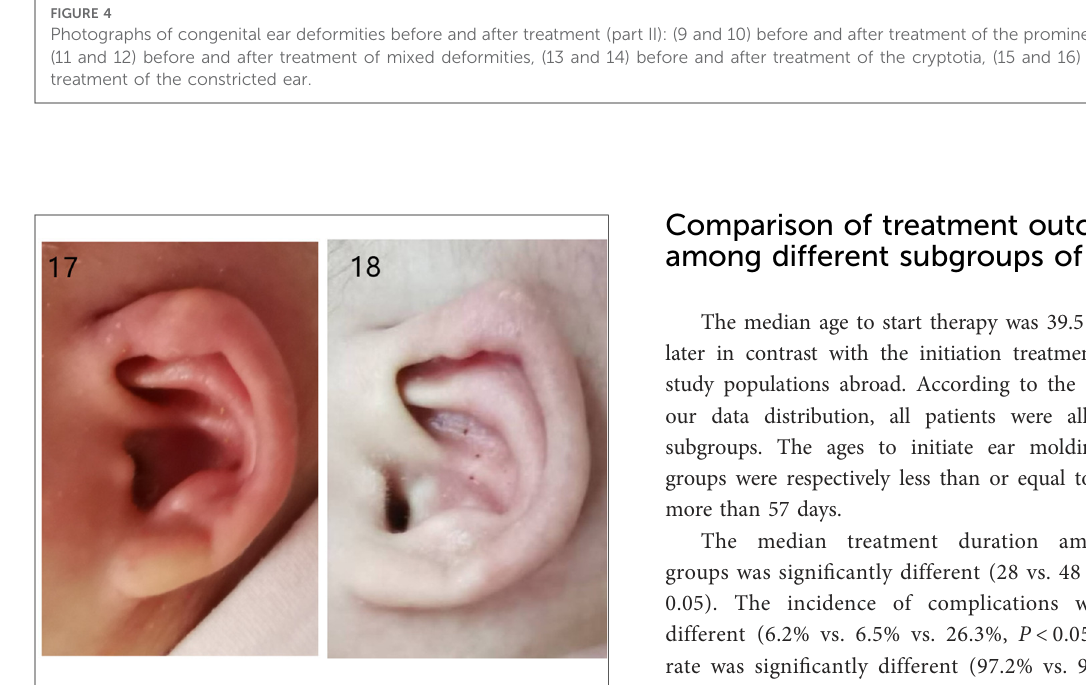
FIGURE 5 Photographs of failure therapy before and after treatment: (17 and 18) before and after treatment of 4-month-old